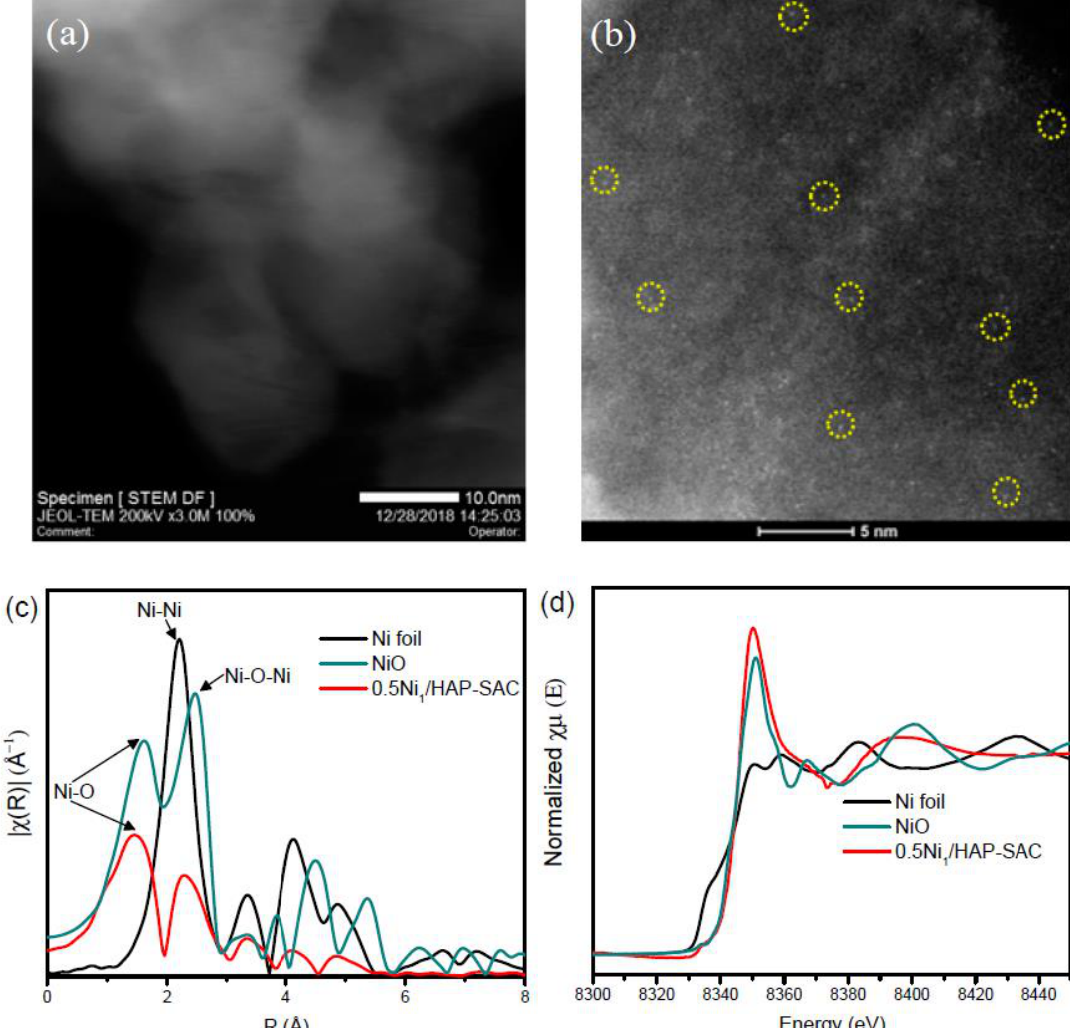
Figure 5. ( a ) STEM image of as-prepared 0.5Ni 1 /HAP-SAC catalyst; ( b ) Aberration-Corrected scanning transmission electron microscopy (AC-STEM) for as-prepared 0.5Ni 1 /HAP-SAC catalyst; ( c ) Fourier transform EXAFS spectrum of the in-situ reduced 0.5Ni 1 /HAP-SAC catalyst at 500 °C in comparison with NiO and Ni foil at the Ni L 2 -edge; ( d ) XANES spectra at the Ni L 2 -edge of NiO, Ni foil and reduced 0.5Ni 1 /HAP-SAC catalyst at 500 °C.